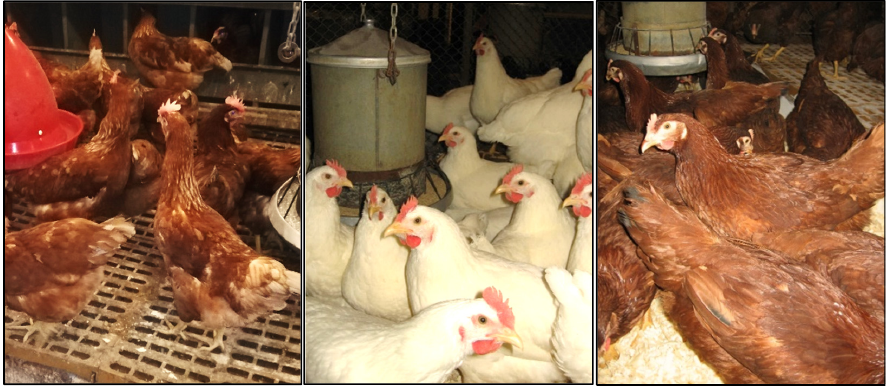
Figure 1. Experimental stocks with three different genetic backgrounds (commercial hybrid (left), purebred offspring of maternal (in the middle) and paternal lines (right)). A total of 53 nineteen-week-old pullets (1041 cm 2 /hen) were housed in the 12 alter- native pens, each with a floor area of 5.52 m 2 . In each pen, 1/3 of the floor space consisted of a scratching area littered with wood shavings, while the remaining 2/3 of the floor space consisted of an elevated plastic grid floor (Figure 2).